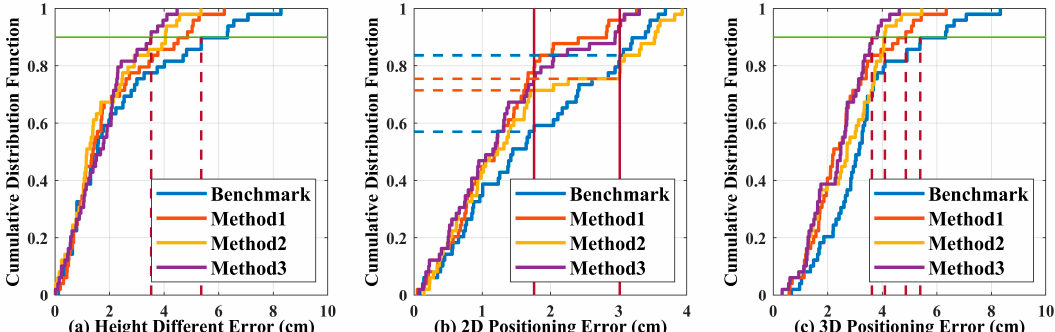
Figure 6. The cumulative distribution function of ( a ) height, ( b ) 2D, and ( c ) 3D positioning errors at Plane 2 in the case of dis (1,2) = 40 cm.